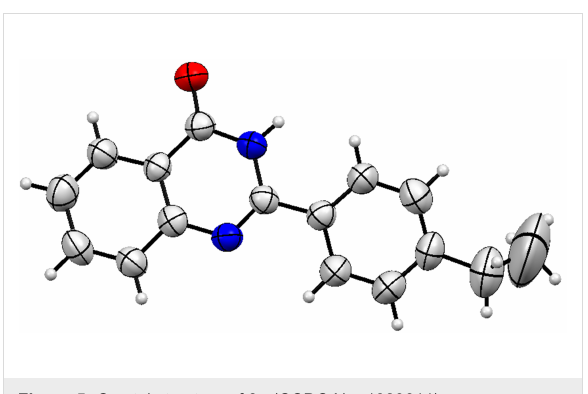
Figure 5: Crystal structure of 3a (CCDC No.